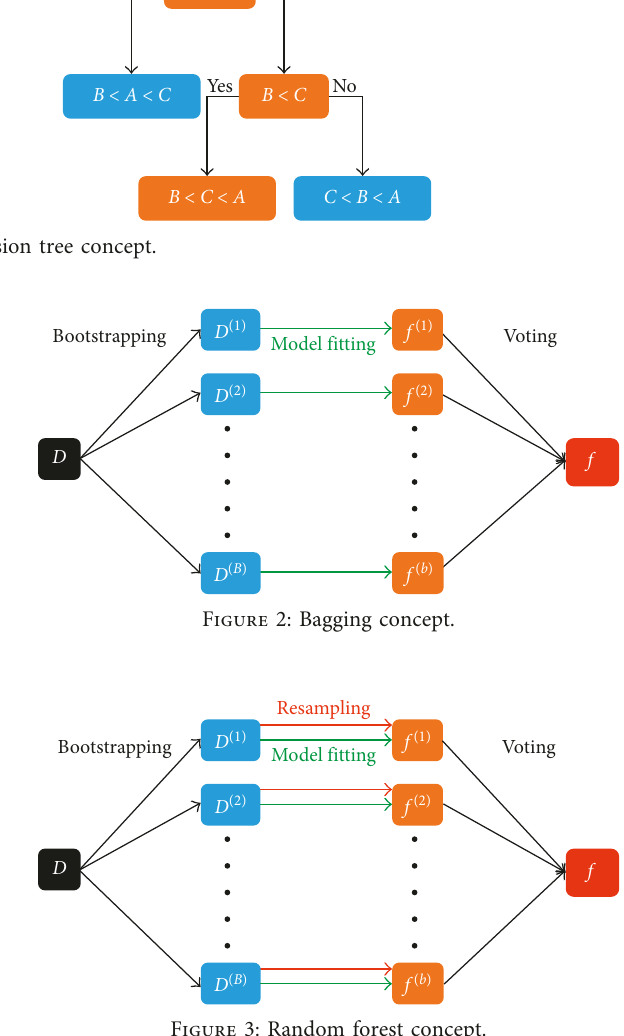
Figure 3: Random forest